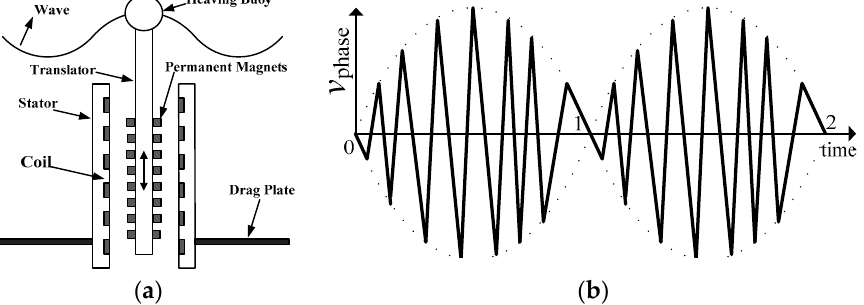
Figure 1. ( a ) Structure of a permanent-magnet linear generator, ( b ) typical waveform of phase voltage of a linear-generator output ( v phase ).